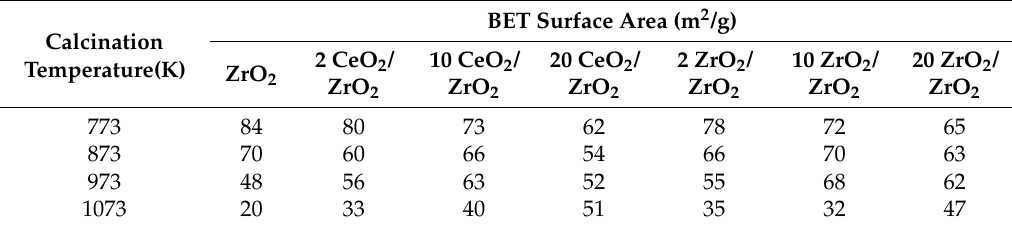
Table 1. BET surface areas as a function of calcination